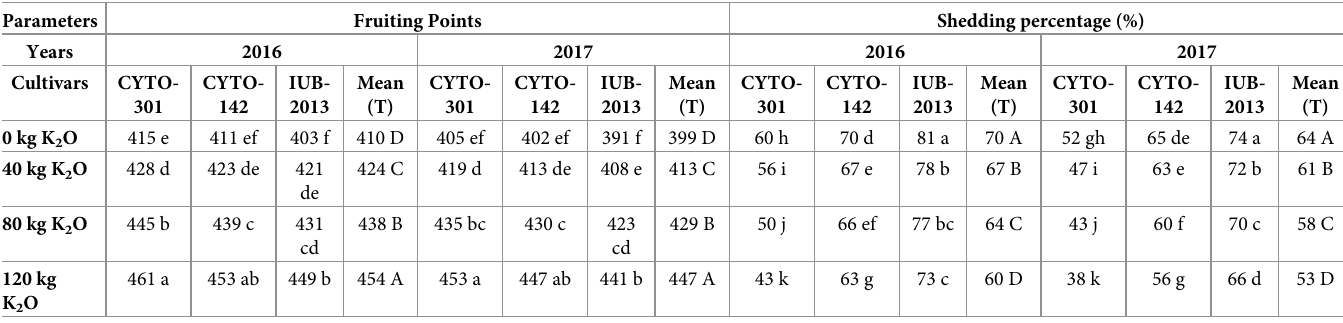
Table 3. Impact of different levels of soil applied K 2 O on fruiting points and shedding percentage of cotton cultivars grown under K deficient soil. Parameters Fruiting Points Shedding percentage (%)